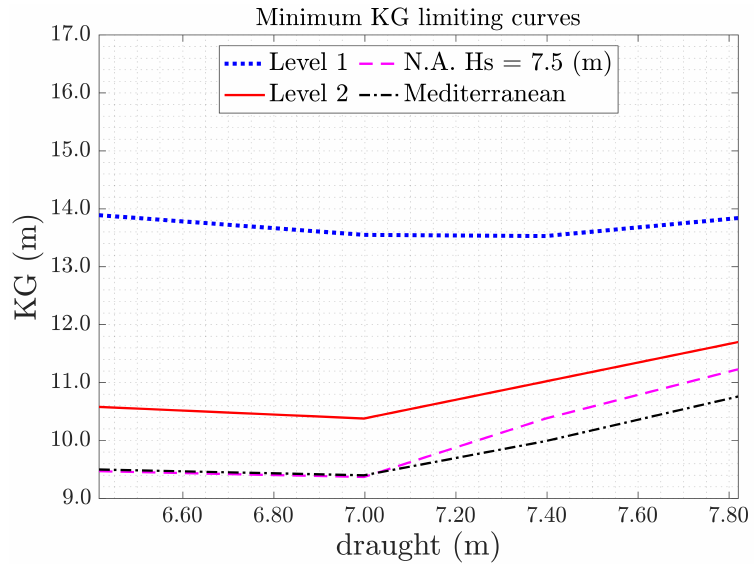
Figure 8. Vulnerability assessment in terms of minimum KG limiting curve for the excessive acceleration failure mode. Curves obtained according to the results for the application of Level 1, Level 2, Level 2 for North Atlantic Ocean limited to Hs = 7.5 (m) and Level 2 for